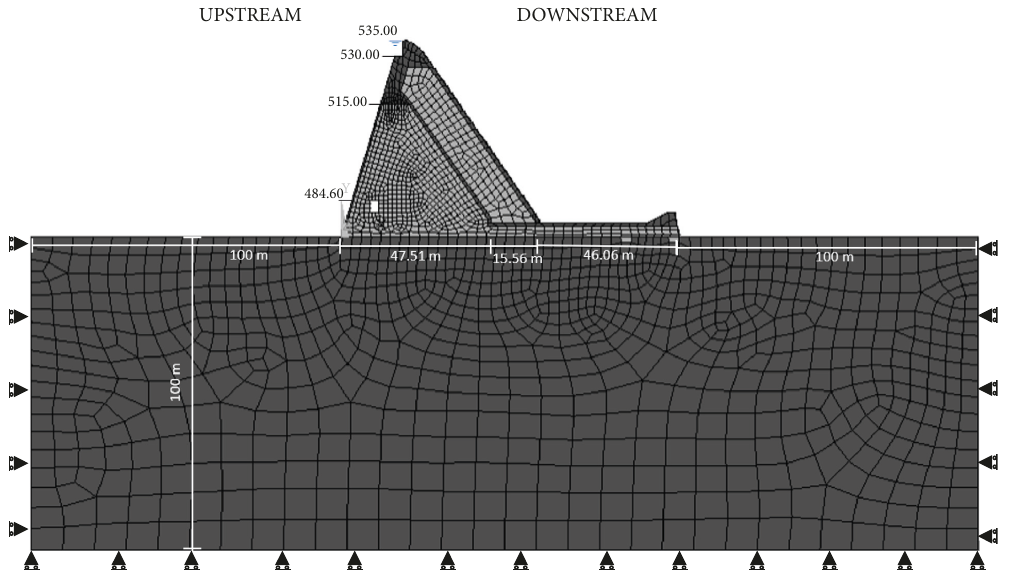
Figure 6: Dimensions and boundary conditions of the